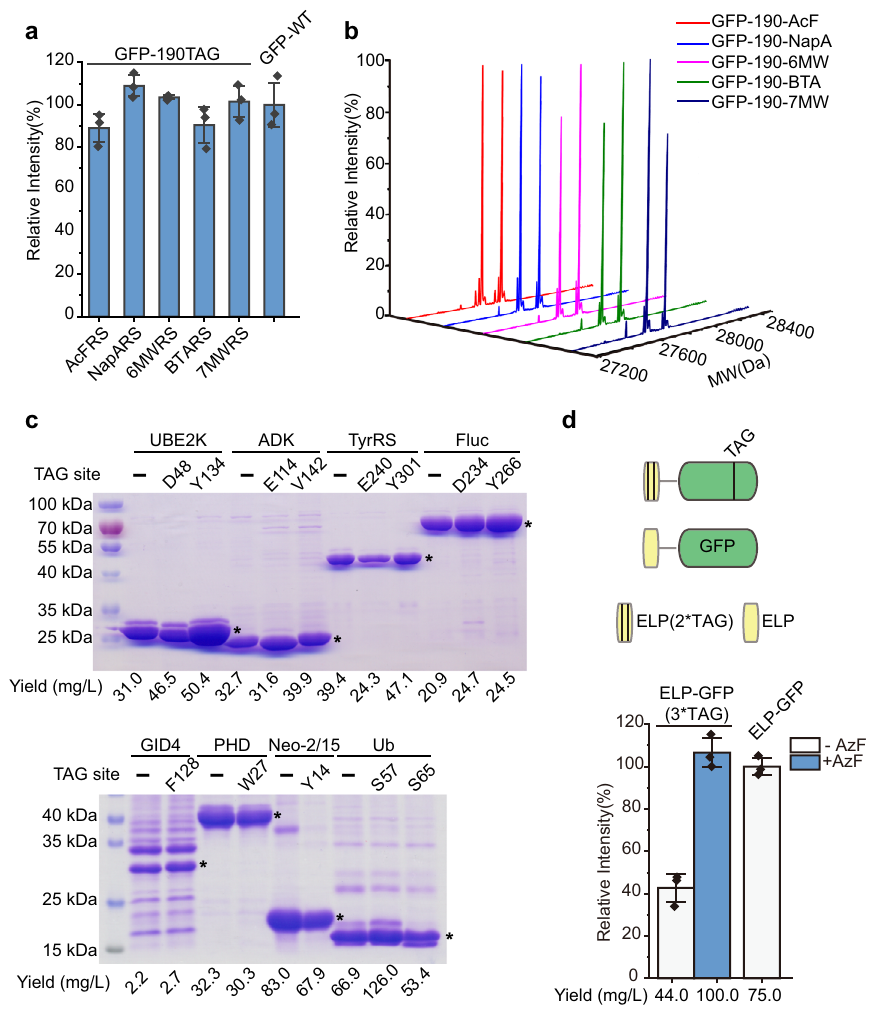
Fig. 4 Single-site and multi-site incorporation of UAAs. a Amber suppression ef fi ciency of the indicated 12D4-chPheRS variants is tested in the presence of their cognate UAAs. The detailed mutation information is shown in Supplementary Table 1. b Mass spectrometry characterization of the fi delity of UAA incorporation into GFP with the indicated 12D4-chPheRS variants. The expected MW from left to right are 27797, 27805, 27808, 27812, and 27808Da, and the observed MW are 27798, 27806, 27809, 27811, and 27809 Da. In each spectrum, N ′ -Met cleaved peaks are also detected. c Analysis of amber suppression activity by the evolved 12D4-AzFRS-2/3C11-chPheT pair at the indicated position of eight proteins by detecting expression of full-length protein using wild-type proteins as positive controls. The major bands indicated by stars in Coomassie blue staining gel are the corresponding full-length proteins. The puri fi ed protein yield is shown below the gel for side-by-side comparison. The experiment in the fi gure was repeated twice with similar results. d Schematic illustration of reporter ELP-GFP, in which a black line indicates one amber codon. WT-ELP-GFP is used as the control. Amber suppression ef fi ciency of the evolved chimeric Phe system incorporates three-site AzFs into ELP-GFP. The puri fi ed protein yield is shown below the fi gure. Error bars represents ±standard error of the mean from three biologically independent experiments. Source data are provided as a Source Data fi